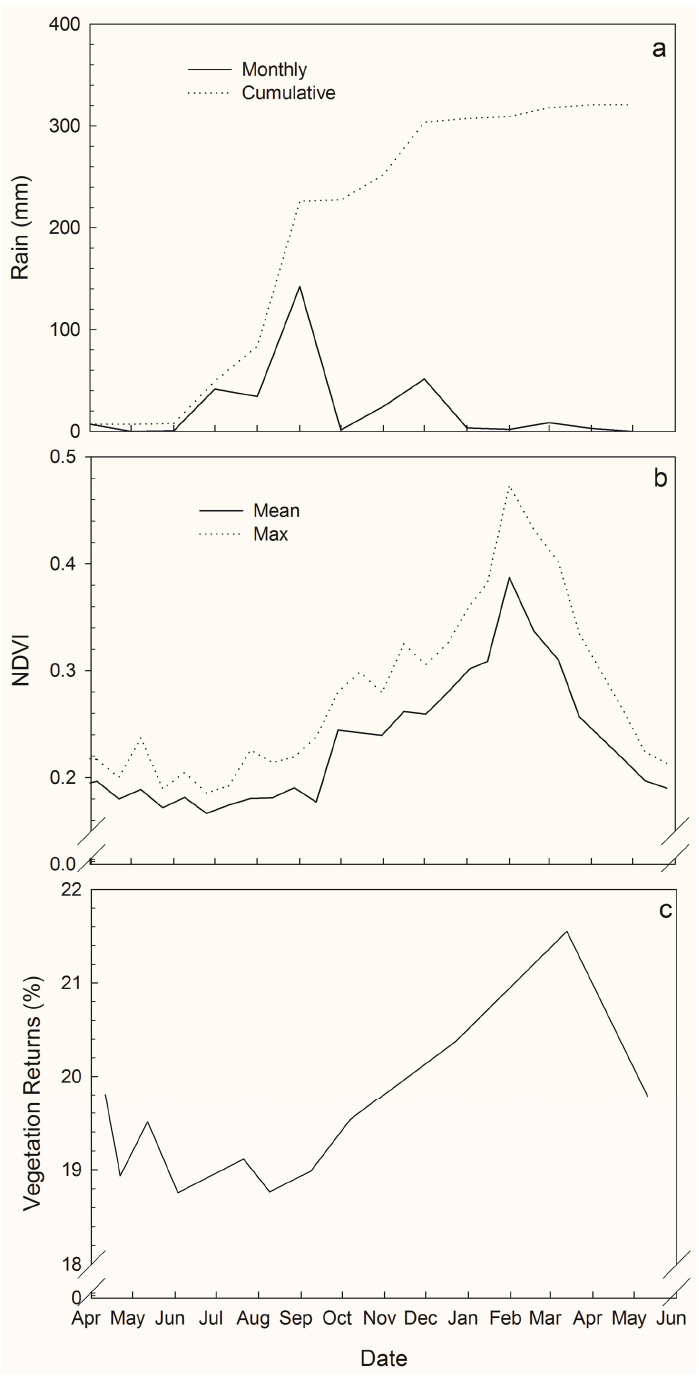
Figure 4. Time series of ( a ) monthly rainfall at the study area; ( b ) MODIS 16-day composite satellite-derived vegetation greenness (NDVI) at the study area; ( c ) percentage of LiDAR returns classified as vegetation ( i.e. , as opposed to the ground surface) within the study